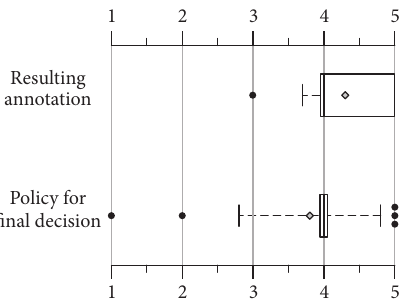
Figure 4: User satisfaction with respect to resulting annotations and decision